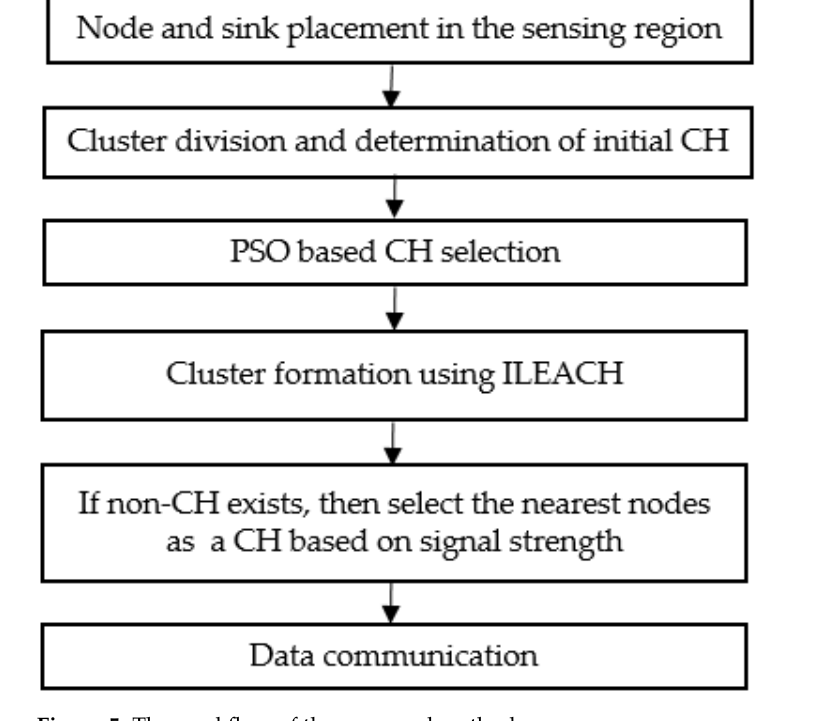
Figure 5. The workflow of the proposed method.